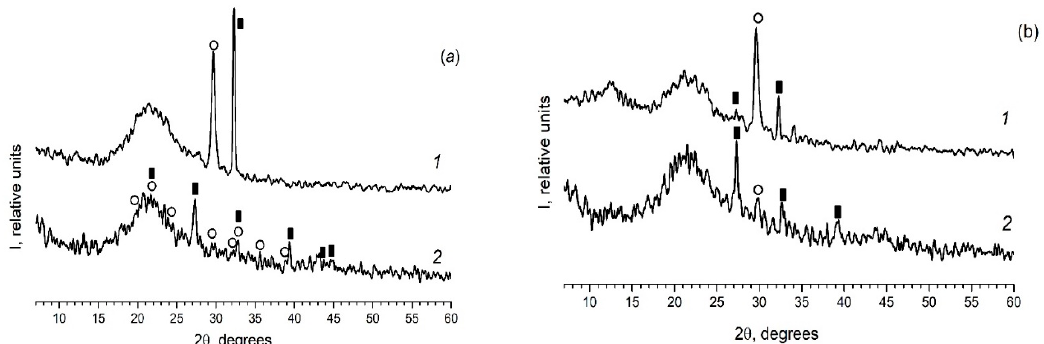
Figure 3. Diffractograms of the composites ( a ) PG-MAP05 and ( b ) PG-MAP1. 1–surface of the sample (plate); 2–volume of the sample (i.e., powder). Black rectangular points refer to the crystalline phase KNO 3 (3–482), open circle points mark the crystalline phase AgNO 3 (74–2076). The IR spectra for PG-MAP-empty porous matrix and composites (PG-MAP05 and PG-MAP1) are presented in Figure 4.